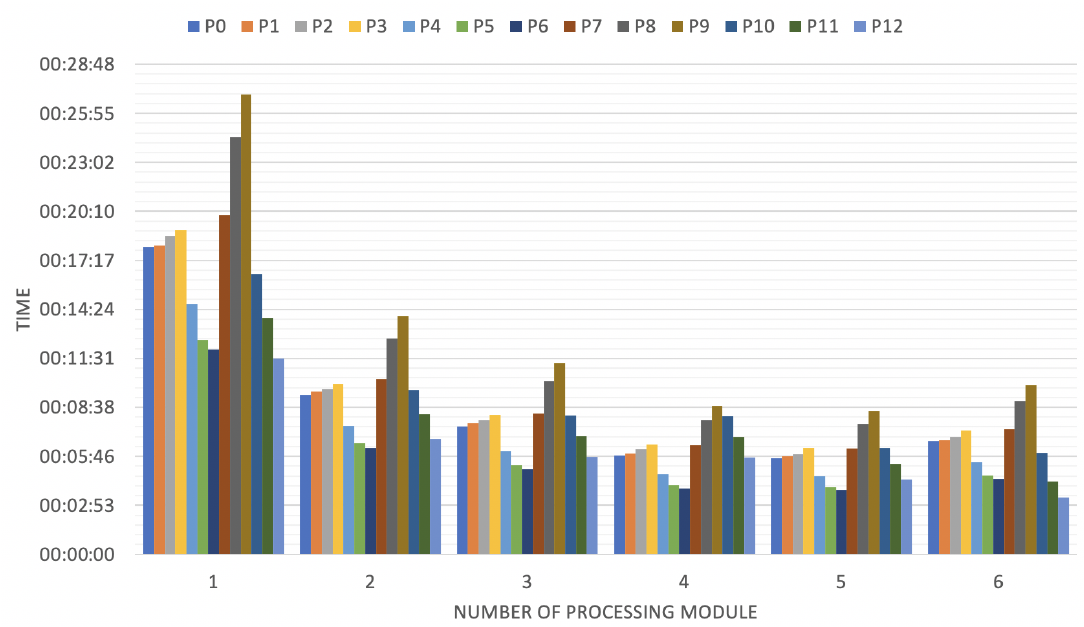
Figure 5. The time consumption in proportion to the number of processing module used and proposed P